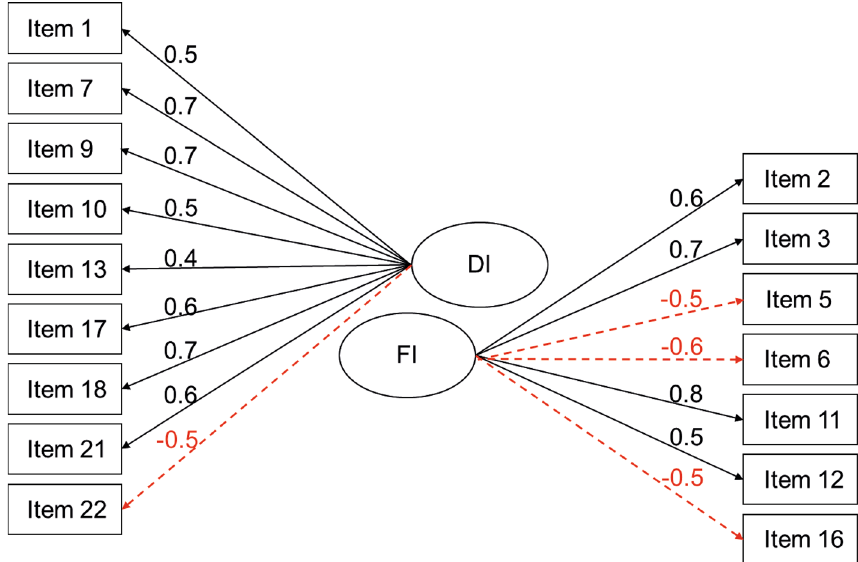
Figure 1. Factor loadings for the dysfunctional (DI) and functional (FI) impulsivity subscale derived from the final exploratory factor analysis model. Item order as proposed by Claes et al. 18 . Negative values (in red) suggest a negative linear association between the latent variable and the observed item.